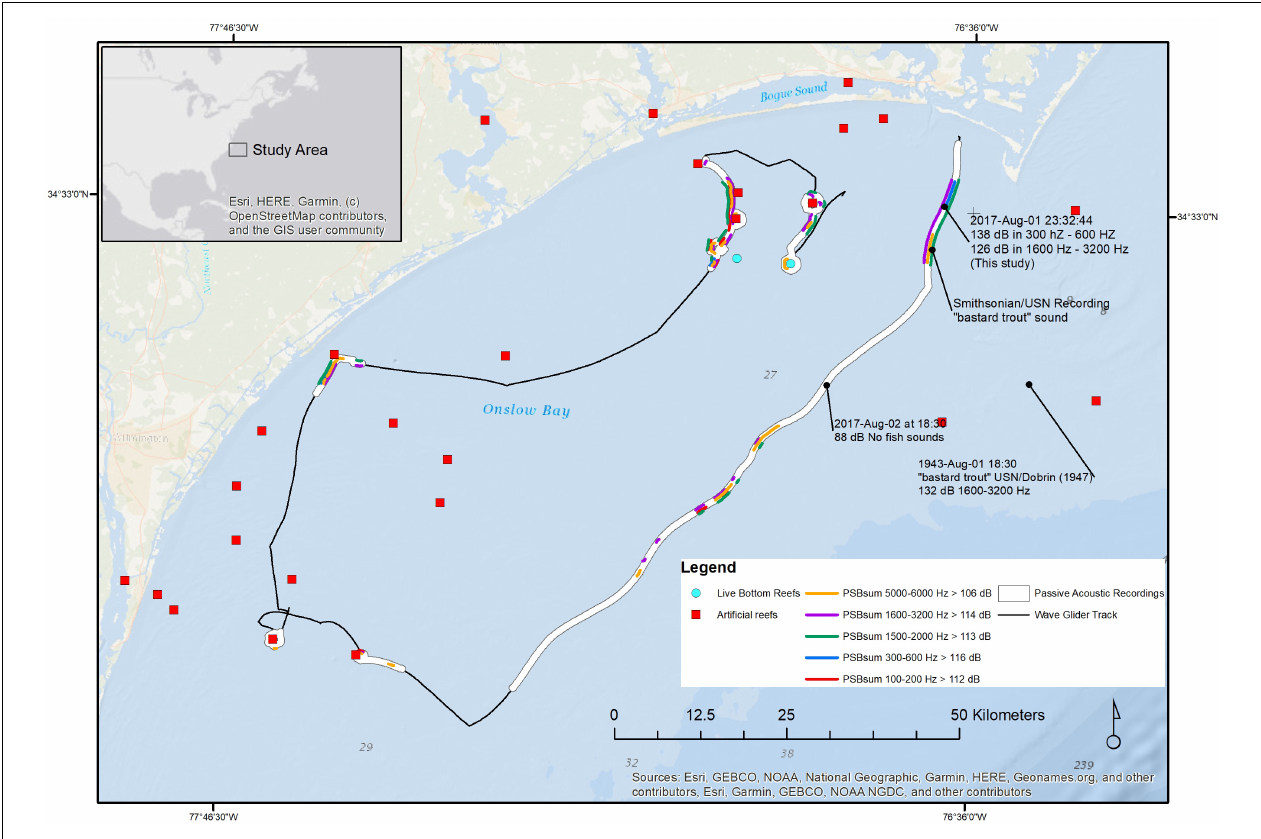
FIGURE 13 | A map of wave glider track (dashed lines; open white circles indicate the position every 4 h, orange filled circles indicate the position at sunset at the time indicated) August-01 through August-09 with the full-spectrum PSD sum (dB re 1 µ Pa 2 /Hz) overlaid on the track. Locations along the track where individual species’ calls and mixed-species fish choruses were recorded are labeled. The locations of artificial reefs (red circles; source: North Carolina Division of Marine Fisheries NCDMF) and known natural reefs (aqua circles) are indicated. The position of a cargo ship on August-01 was obtained from vessel Automatic Identification System (AIS) signals received on the wave glider and are shown as blue